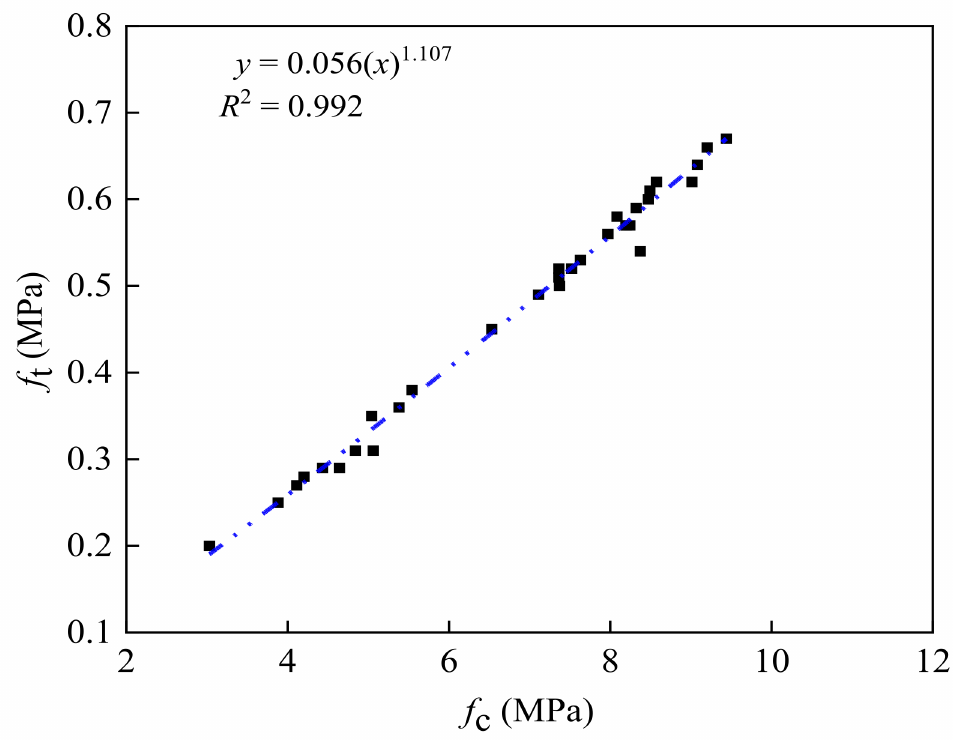
Figure 8. Relationship between the unconfined compressive strength and the splitting